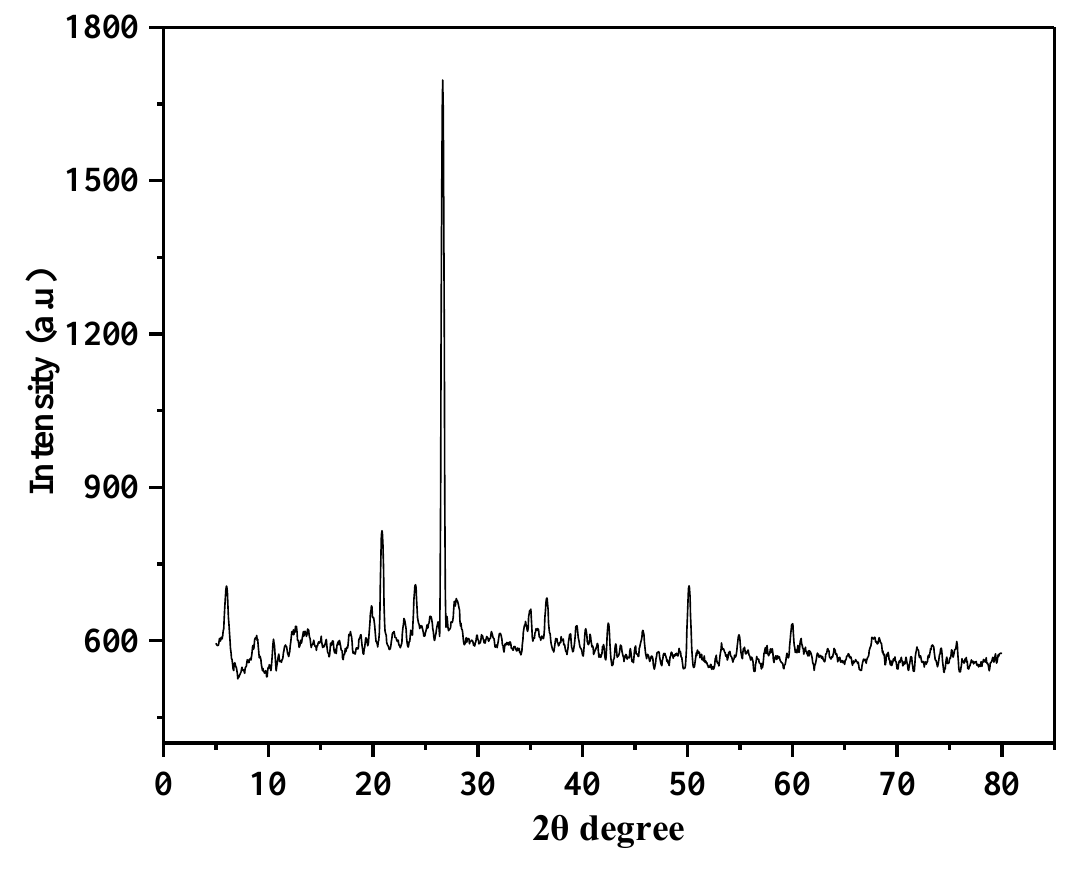
Figure 1. XRD patterns of anthill.